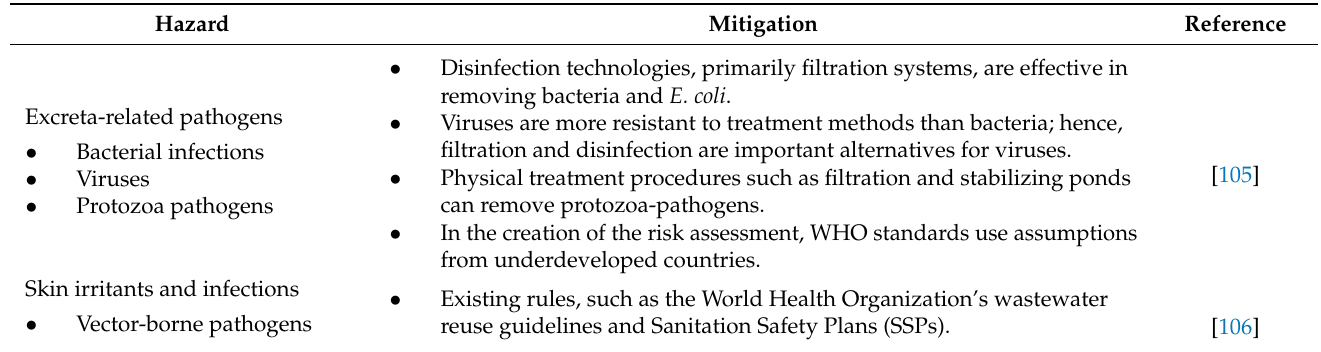
Table 6. Different types of risk-mitigation methods.